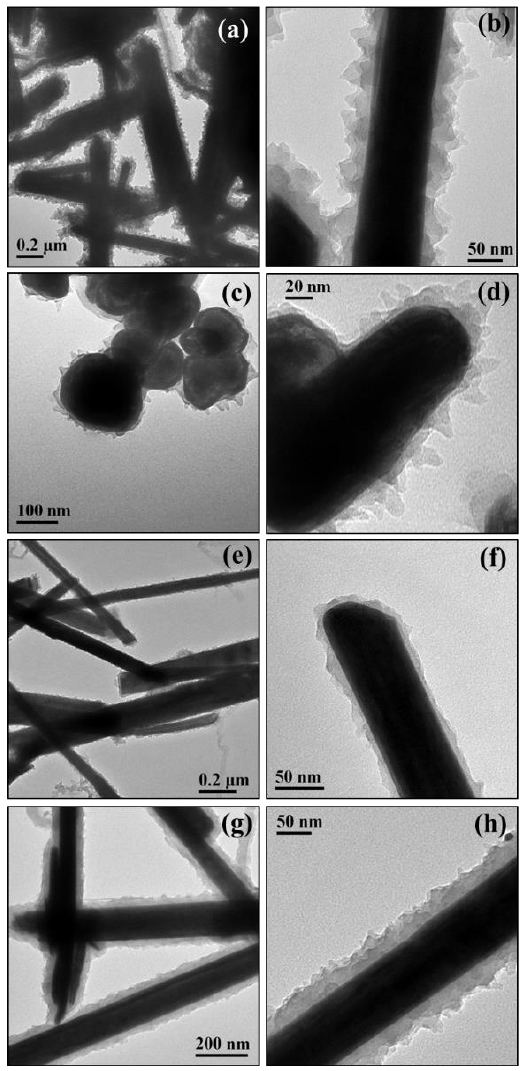
Figure 2. TEM images of WS 2 @SiO 2 nanocomposites: INT-PANI-HA ( a , b ); IF-PANI-HA ( c , d ); INT-PANI-SA1 ( e , f ); INT-PANI-SA2 ( g , h ).